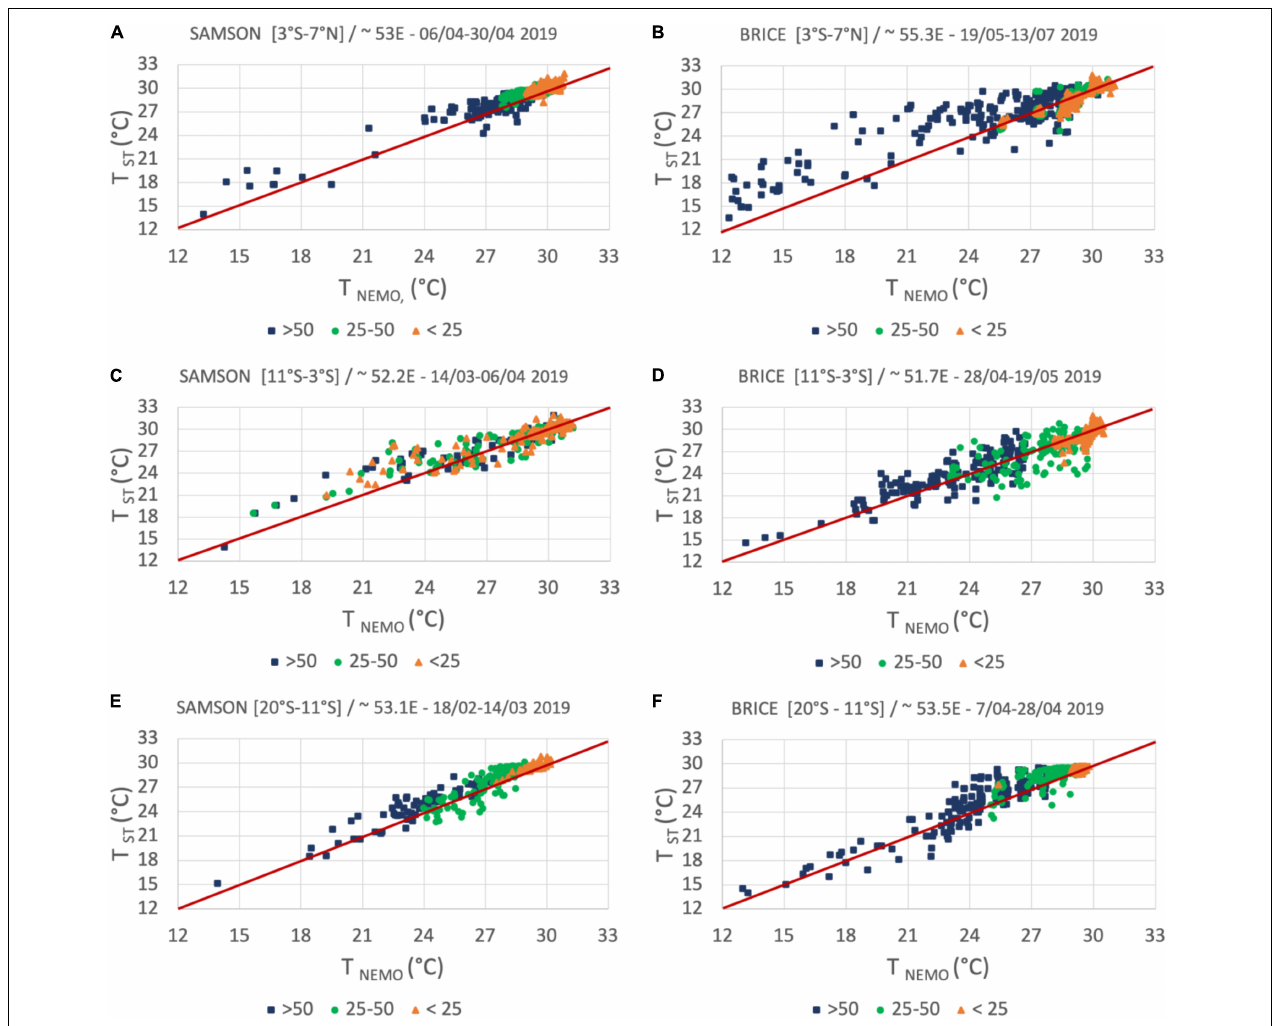
FIGURE 11 | Scatterplots of temperature data collected by STs (T ST ) SAMSON (left panel) and BRICE (right panel) and forecasted by Glo12 (T NEMO ) within latitude bands (A,B) (3 ◦ S–7 ◦ N), (C,D) (3 ◦ S–11 ◦ S), and (E,F) (11 ◦ S–20 ◦ S) shown in Figure 2 . The associated mean longitude and comparison period are given on top of each